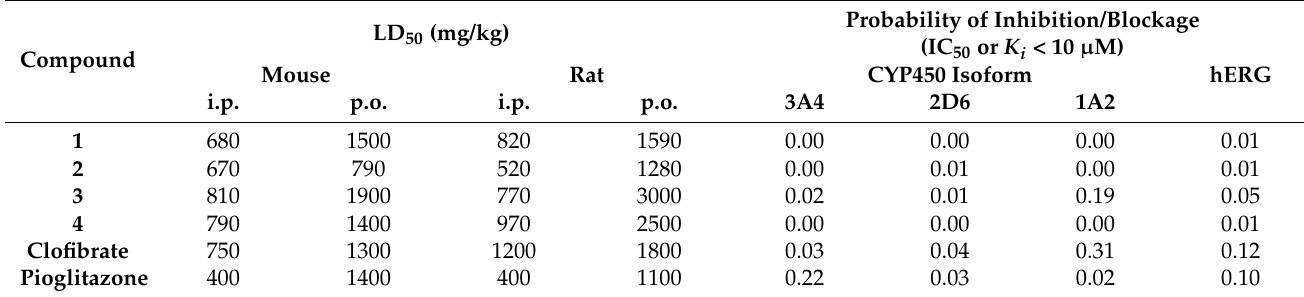
Table 2. Predicted toxicity profiles calculated for compounds 1–4, clofibrate, and pioglitazone.